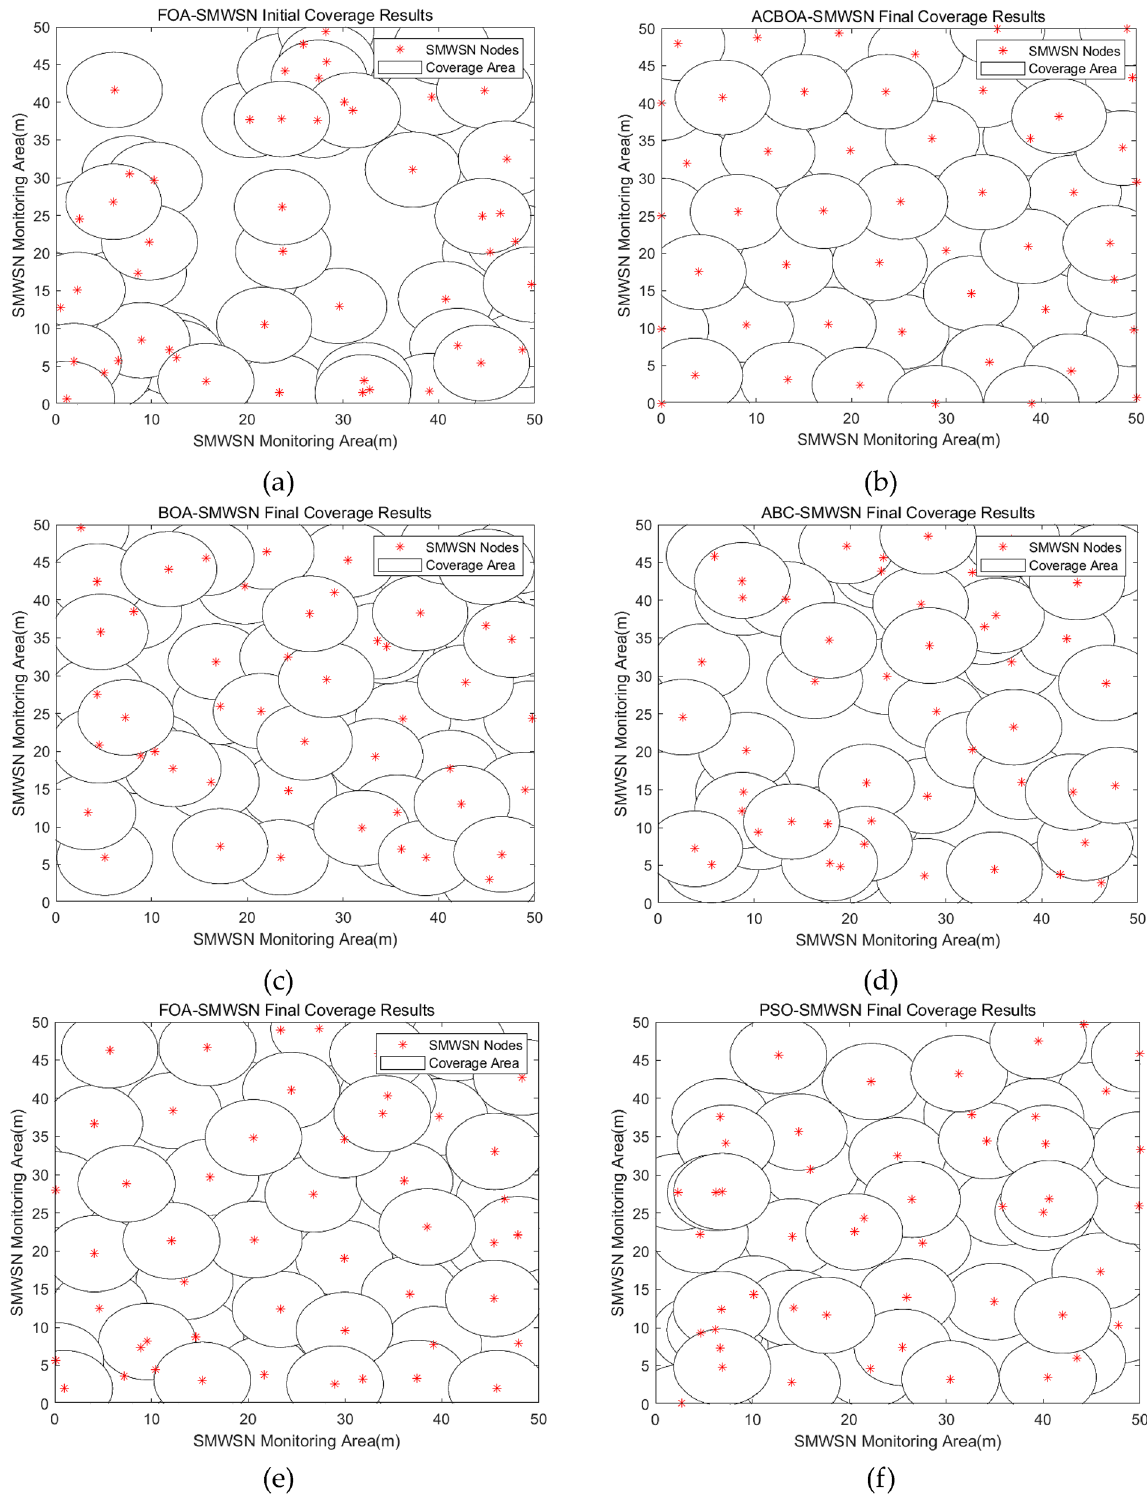
Figure 5. Node deployment when monitoring area 50 m × 50 m, number of nodes 53, sensing radius 5 m, communication radius 10 ± 2 m ( a ) Random deployment, ( b ) ACBOA optimization, ( c ) BOA optimization, ( d ) ABC optimization, ( e ) FOA optimization, ( f ) PSO